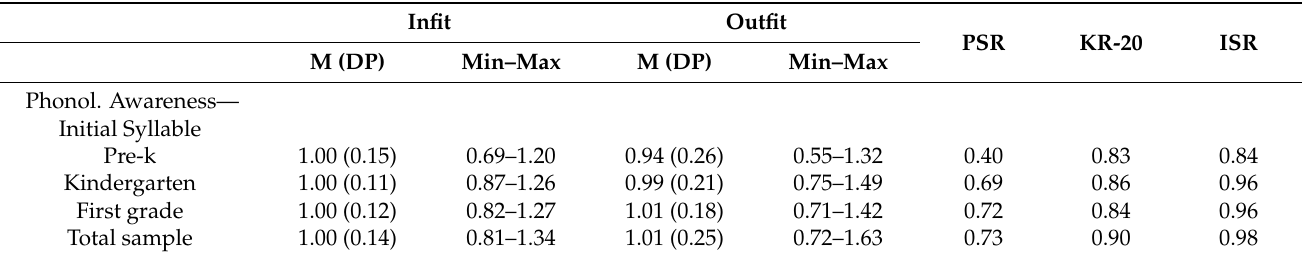
Table 2. Fit indices and reliability for the